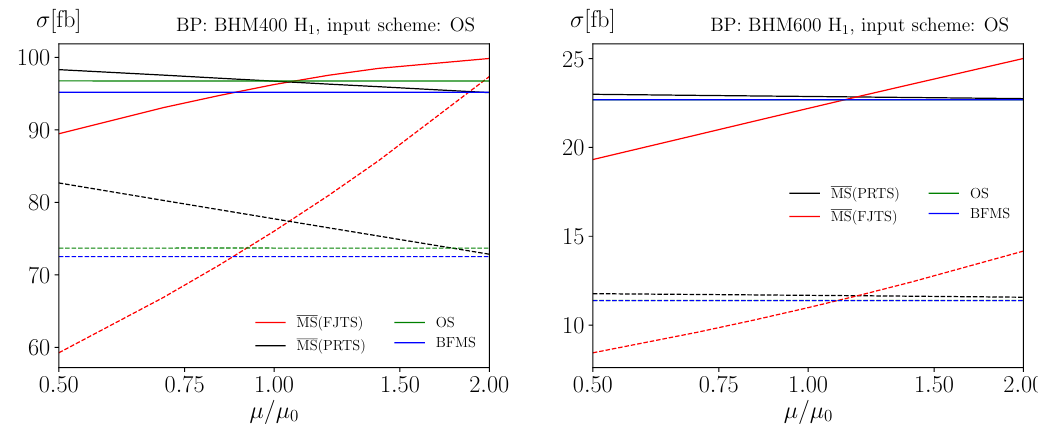
Figure 5 . As in (cid:12)gure 4, but for H 1 production in the benchmark scenarios BHM400 (left) and BHM600